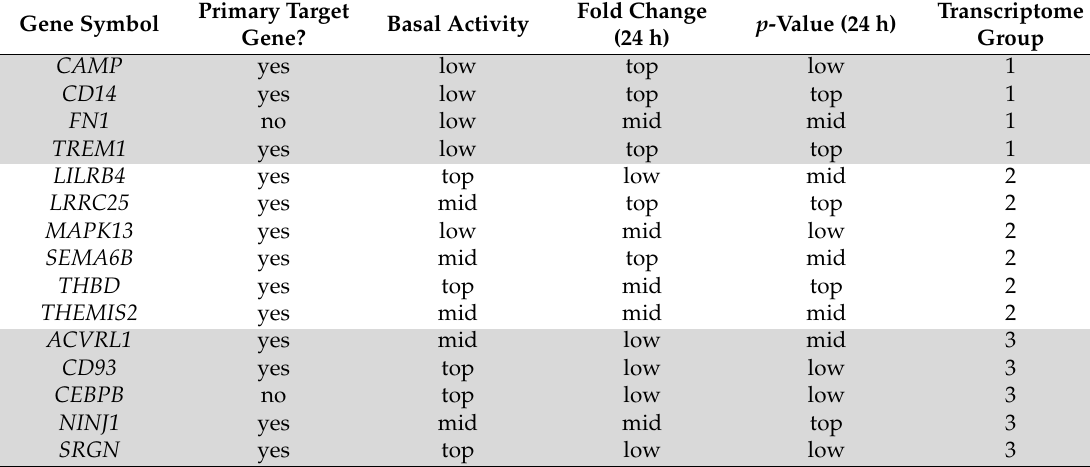
Table 2. Transcriptomic profile of key immune-related vitamin D target genes in THP-1 cells. Based on published RNA-seq data of a time course (2.5, 4 and 24 h) of 1,25(OH) 2 D 3 stimulation in THP-1 cells [29], the 15 key genes were categorized as primary or secondary vitamin D targets and into tertials (top, mid and low) with respect to their basal activity (expression level with solvent control), their inducibility (fold change at 24 h) and sensitivity ( p -value at 24 h). The classification of the genes is based on the steepness of the dynamic response of gene expression to 1,25(OH) 2 D 3 stimulation (Figure 4). Fold Change Primary Target p -Value (24 Basal Activity Gene Symbol (24 h) Gene?